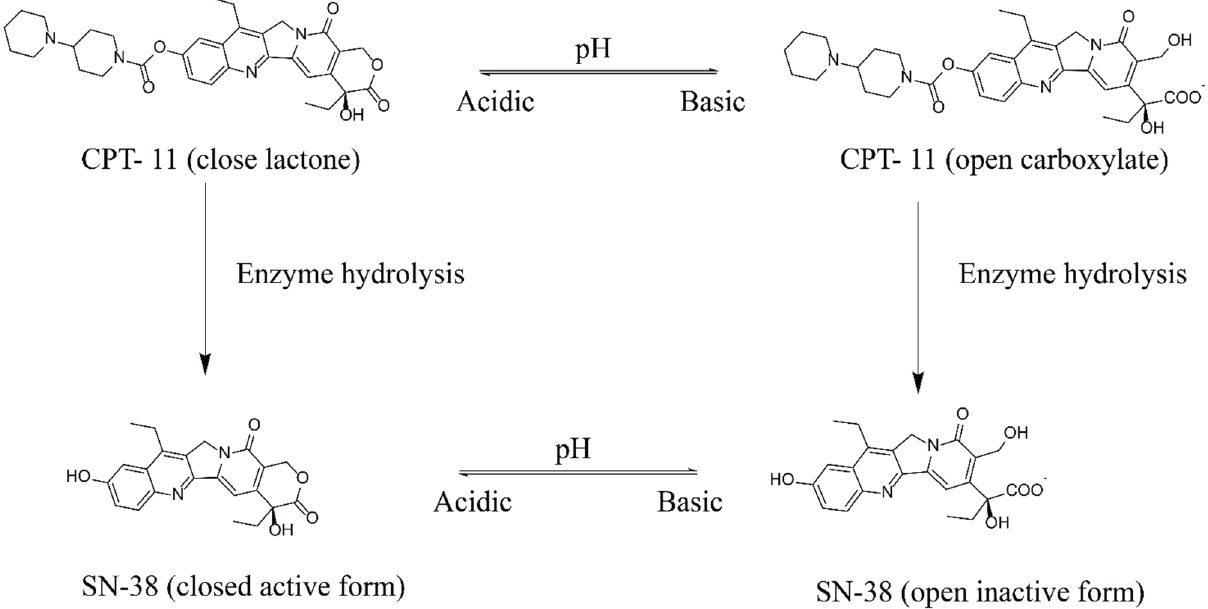
Figure 1. The active form (lactone) chemical structure of Camptothecin derivate CPT-11 and its enzyme hydrolysis to SN-38 and its pH-dependent inactive carboxylate form.